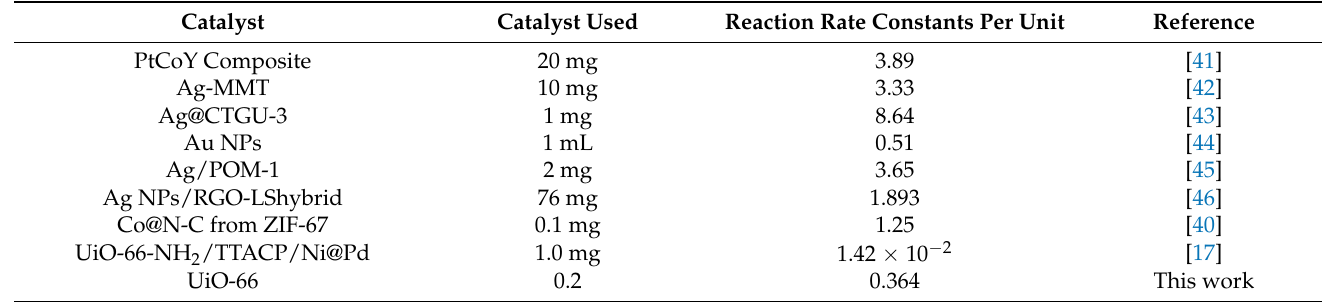
Table 2. Table showing the catalytic performance of different